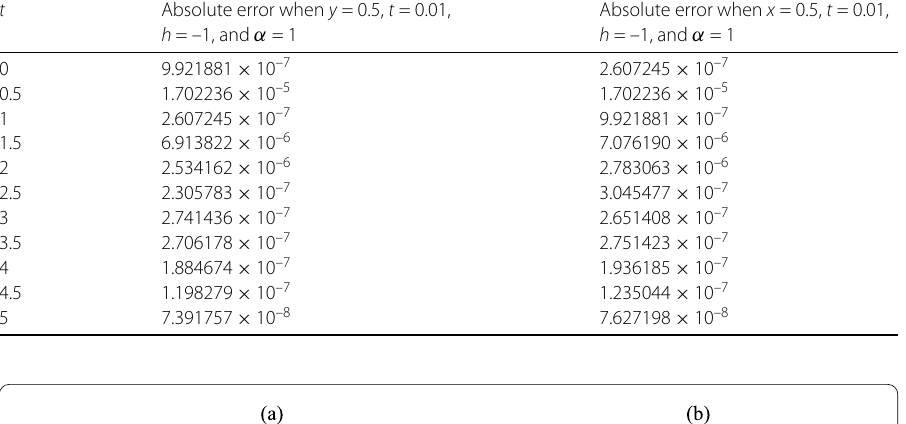
Table 1 The absolute error of the 3-order approximation and the exact solution t Absolute error when y = 0.5, t = 0.01, h = –1, and α =